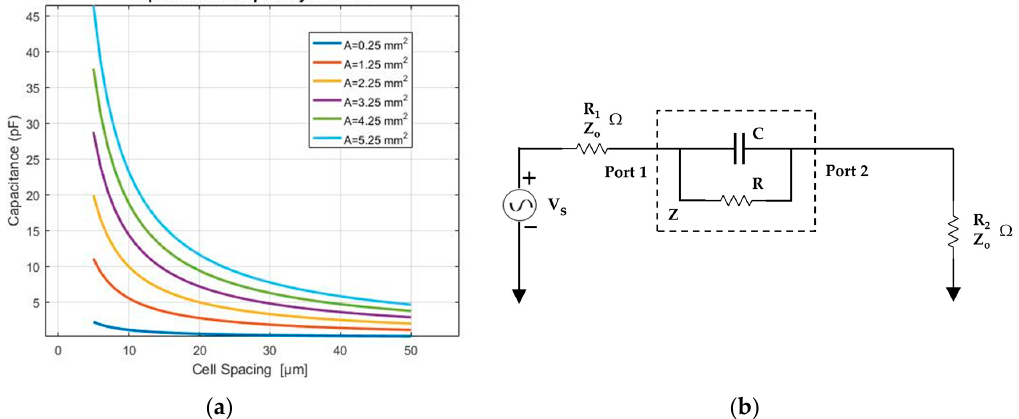
Figure 20. ( a ) Capacitance values as a function of cell distances and areas; ( b ) an LC composite-based RF device model ignoring the parasitic effects.